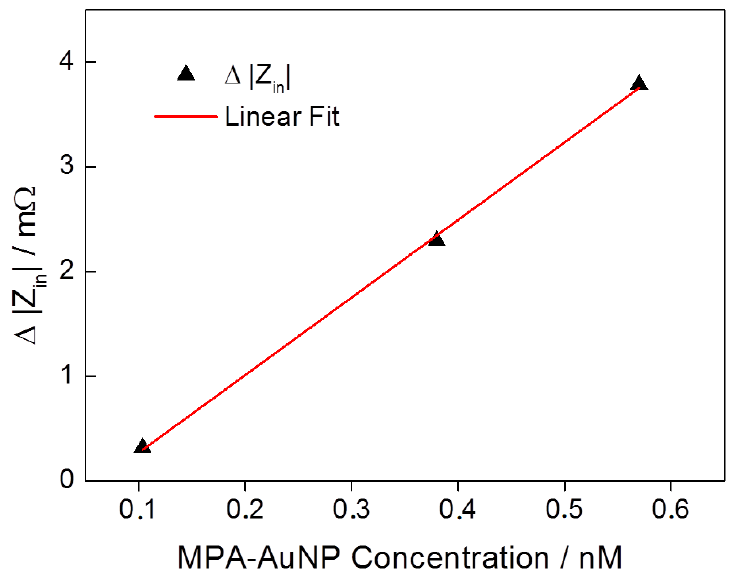
Figure 8. Shift of |Z in | with respect to different MPA–AuNP concentrations in a solution.